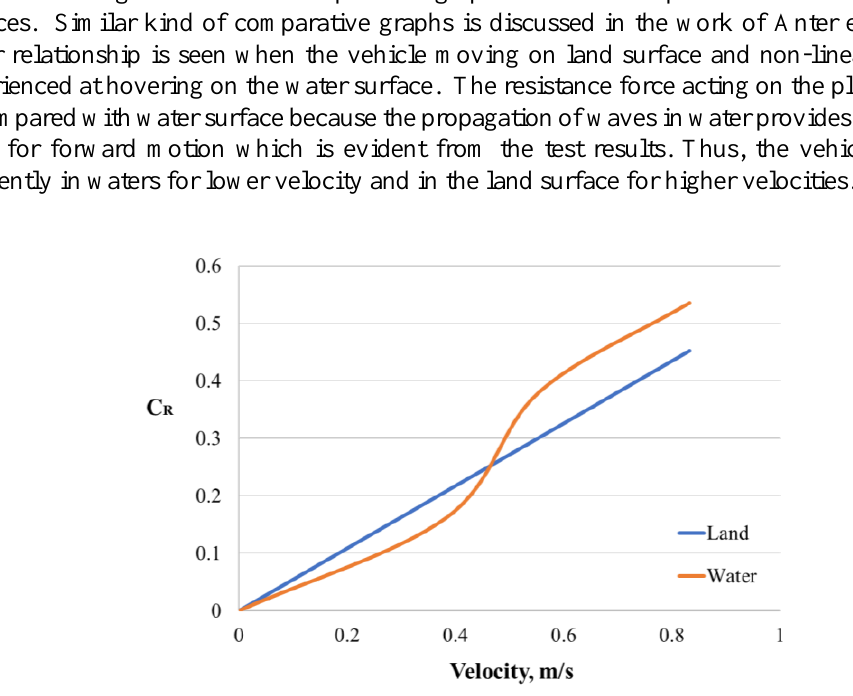
Figure 18. Resistance curve of